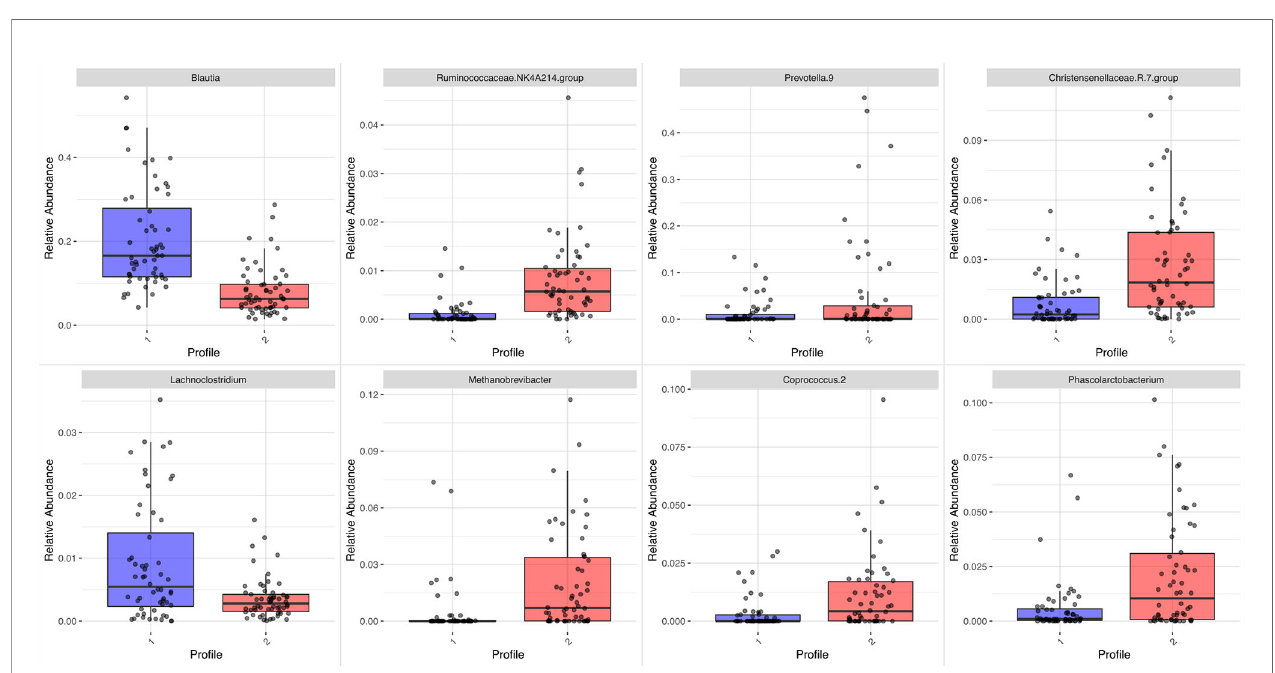
FIGURE 4 | Boxplot of differential abundances of selected genera by pro fi le (#1 in blue is driven by Blautia ; #2 in red is driven by Prevotella ). Adjusted p-value